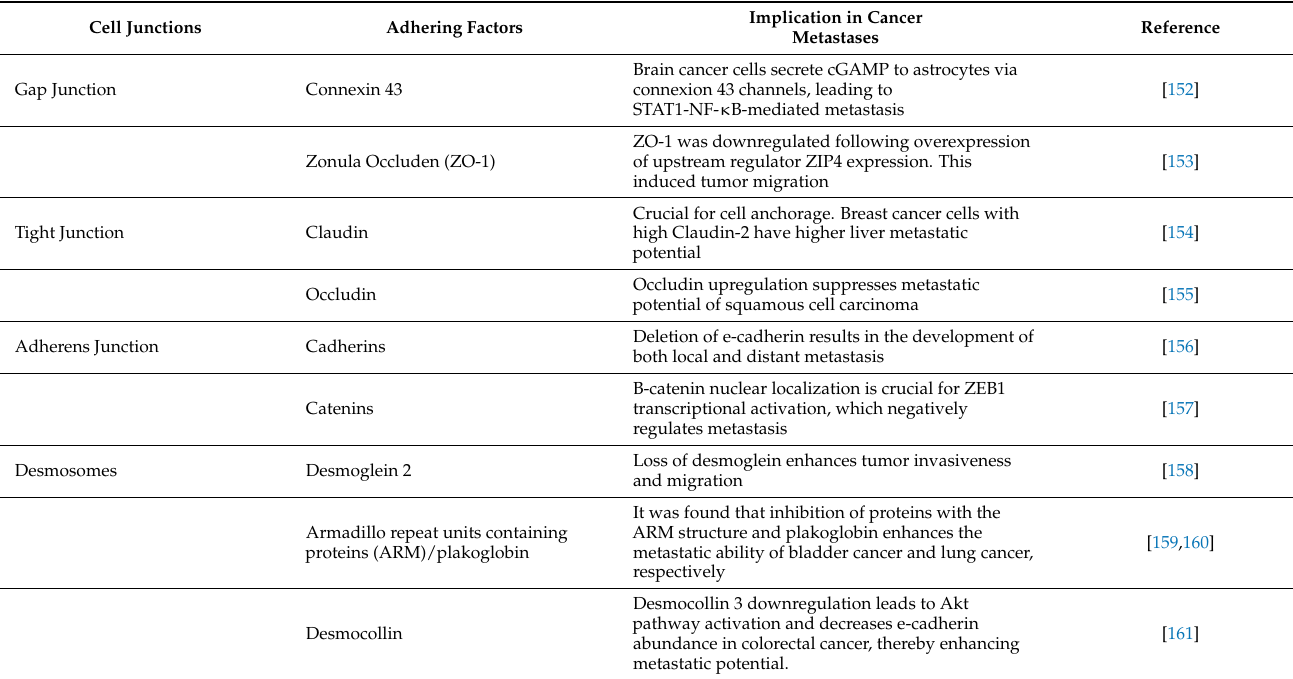
Table 7. Adhering factors found on cell junctions and their implications in metastasis.